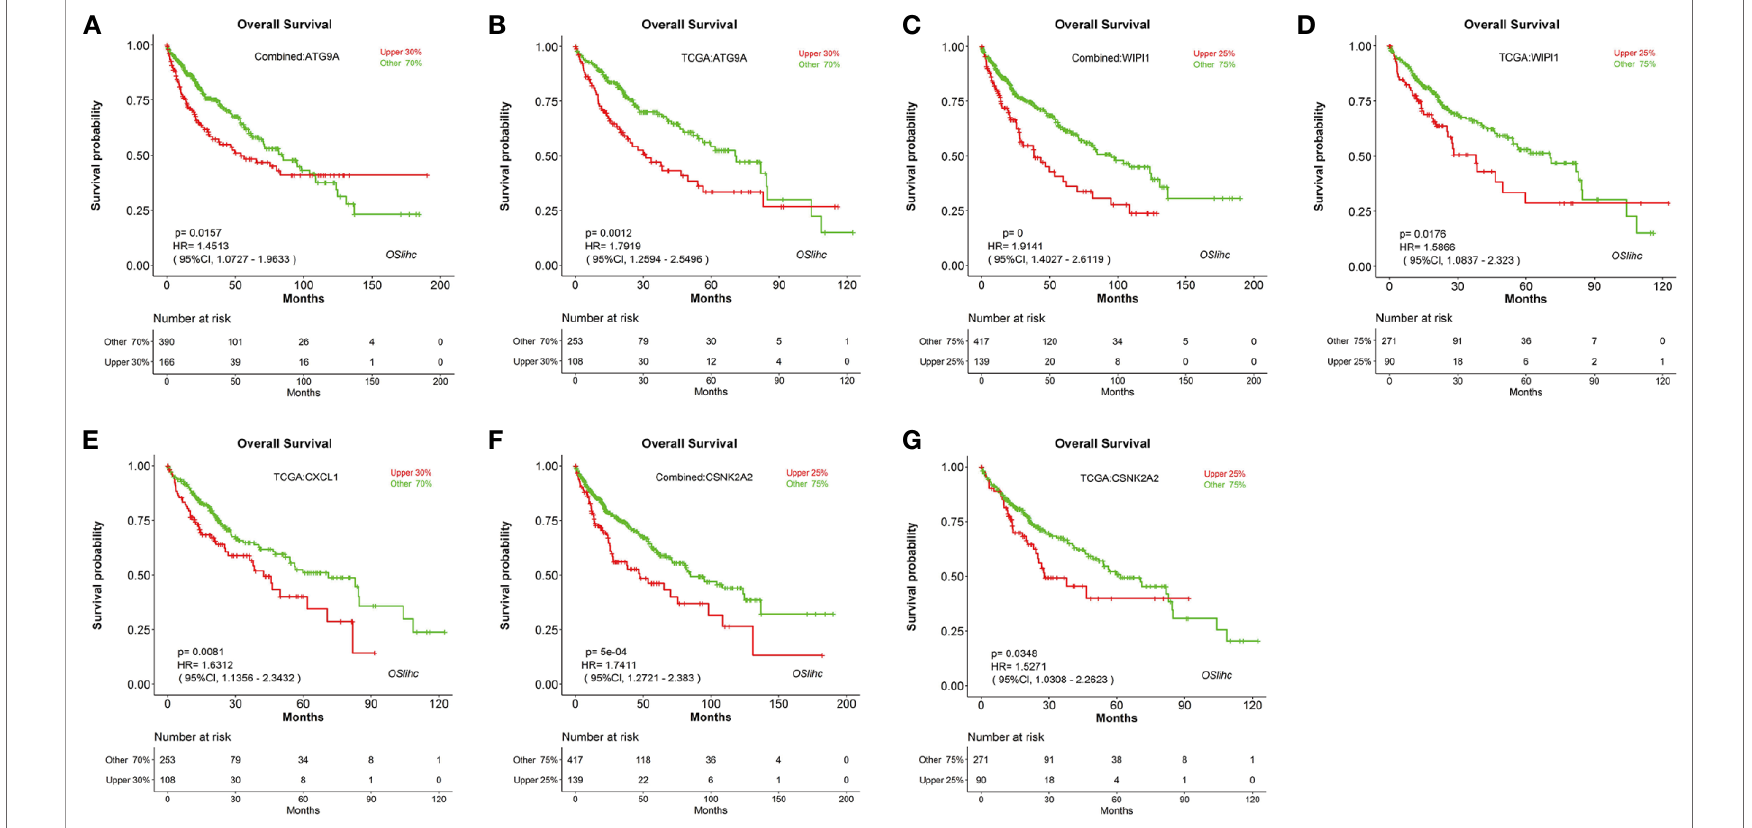
FIGURE 5 | Evaluation of the prognostic values of potential biomarkers in OSlihc. Kaplan – Meier plots for high (red) and low (green) ATG9A , WIPI1 , CXCL1, or CSNK2A2 -expression cohort in combined dataset (A, C , F) and TCGA dataset (B, D, E , G) . p -value, con fi dence interval (95%CI) and number at risk are as shown. The y-axis represents survival rate and the x-axis represents survival time